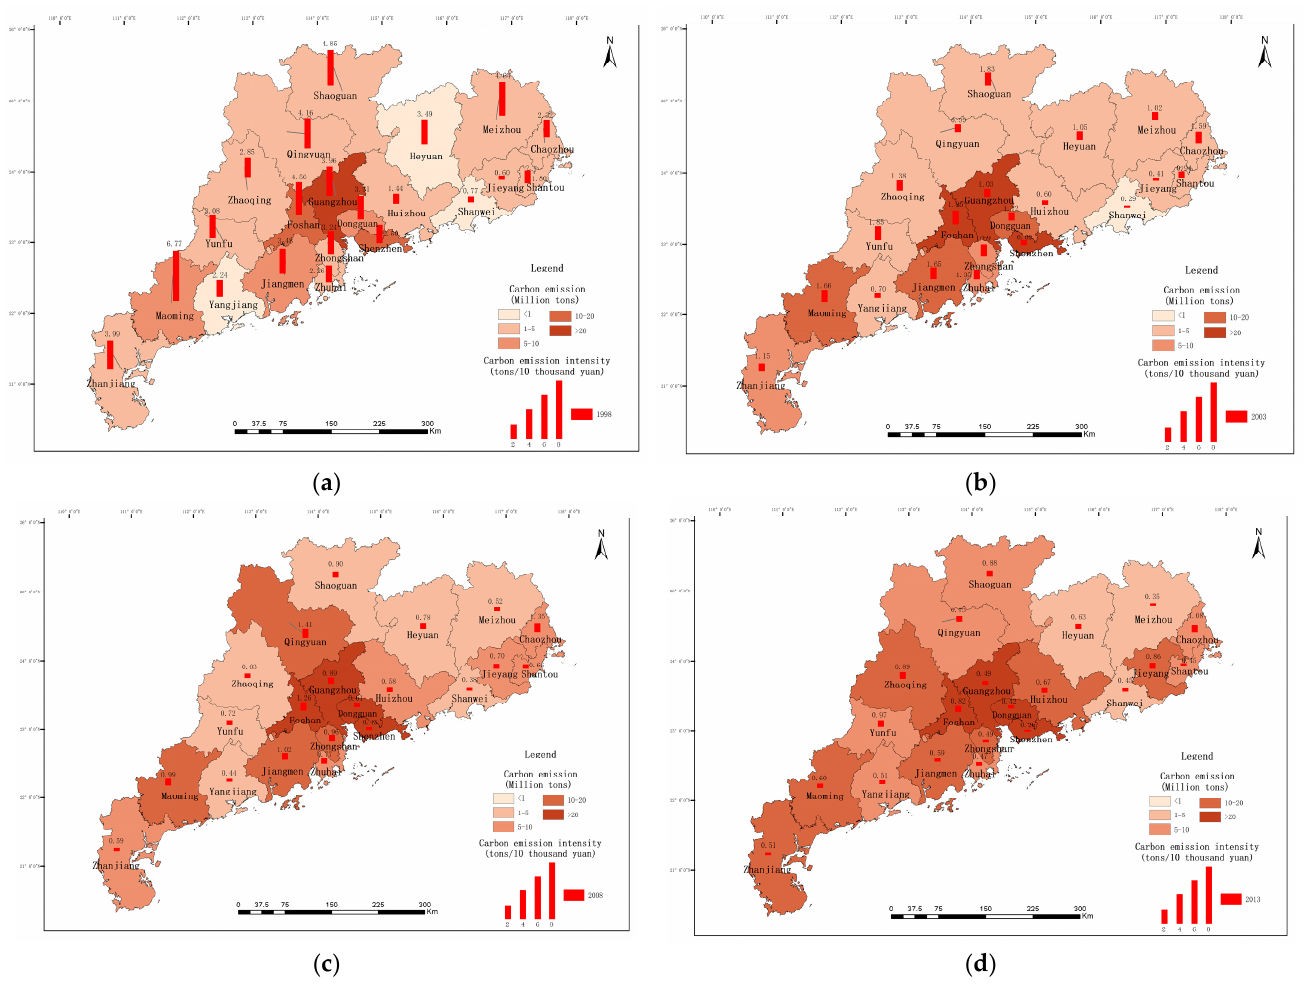
Figure 5. Distribution Diagram of Industrial Carbon Emissions in Guangdong ( a ) 1998; ( b ) 2003; ( c ) 2008; ( d ) 2013.